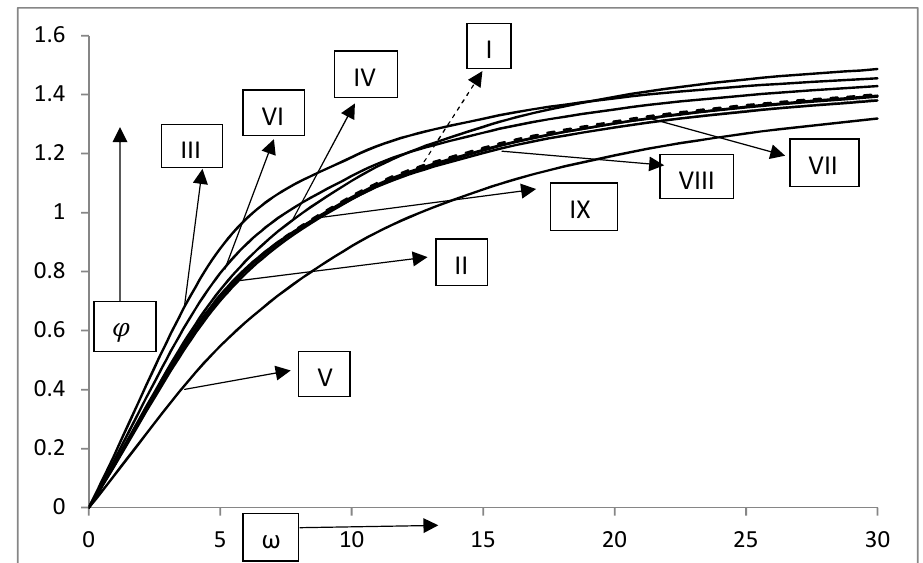
Figure 4. Phase angle of the skin-friction .